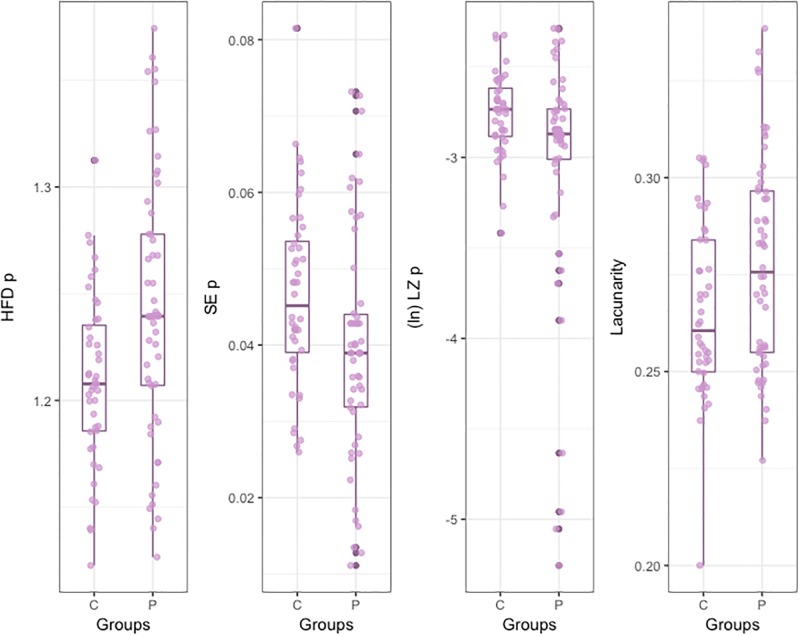
Box Plot for complexity measures for pressure and lacunarity.